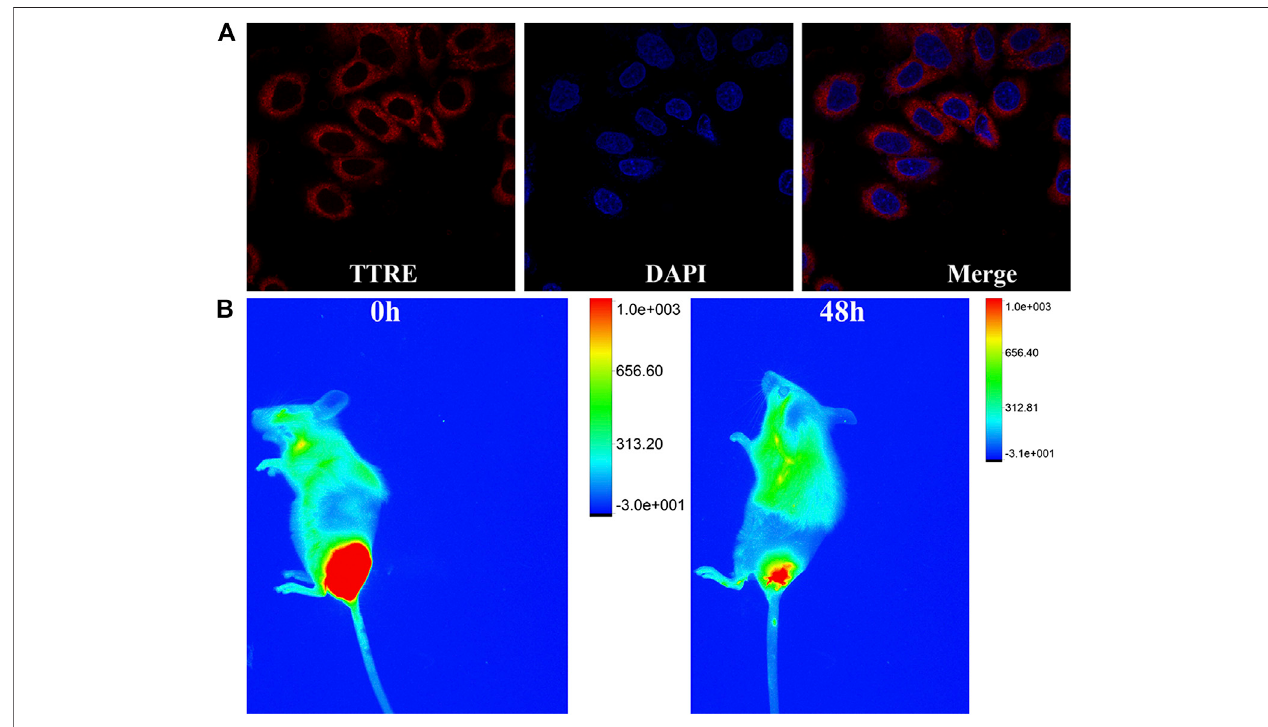
FIGURE 3 |(A) Fluorescent imaging of 4T1 cells coculture with TTRE. (B) The fl uorescent imaging of 4T1 tumor-bearing mice after intratumorally injection of TTRE in vivo .